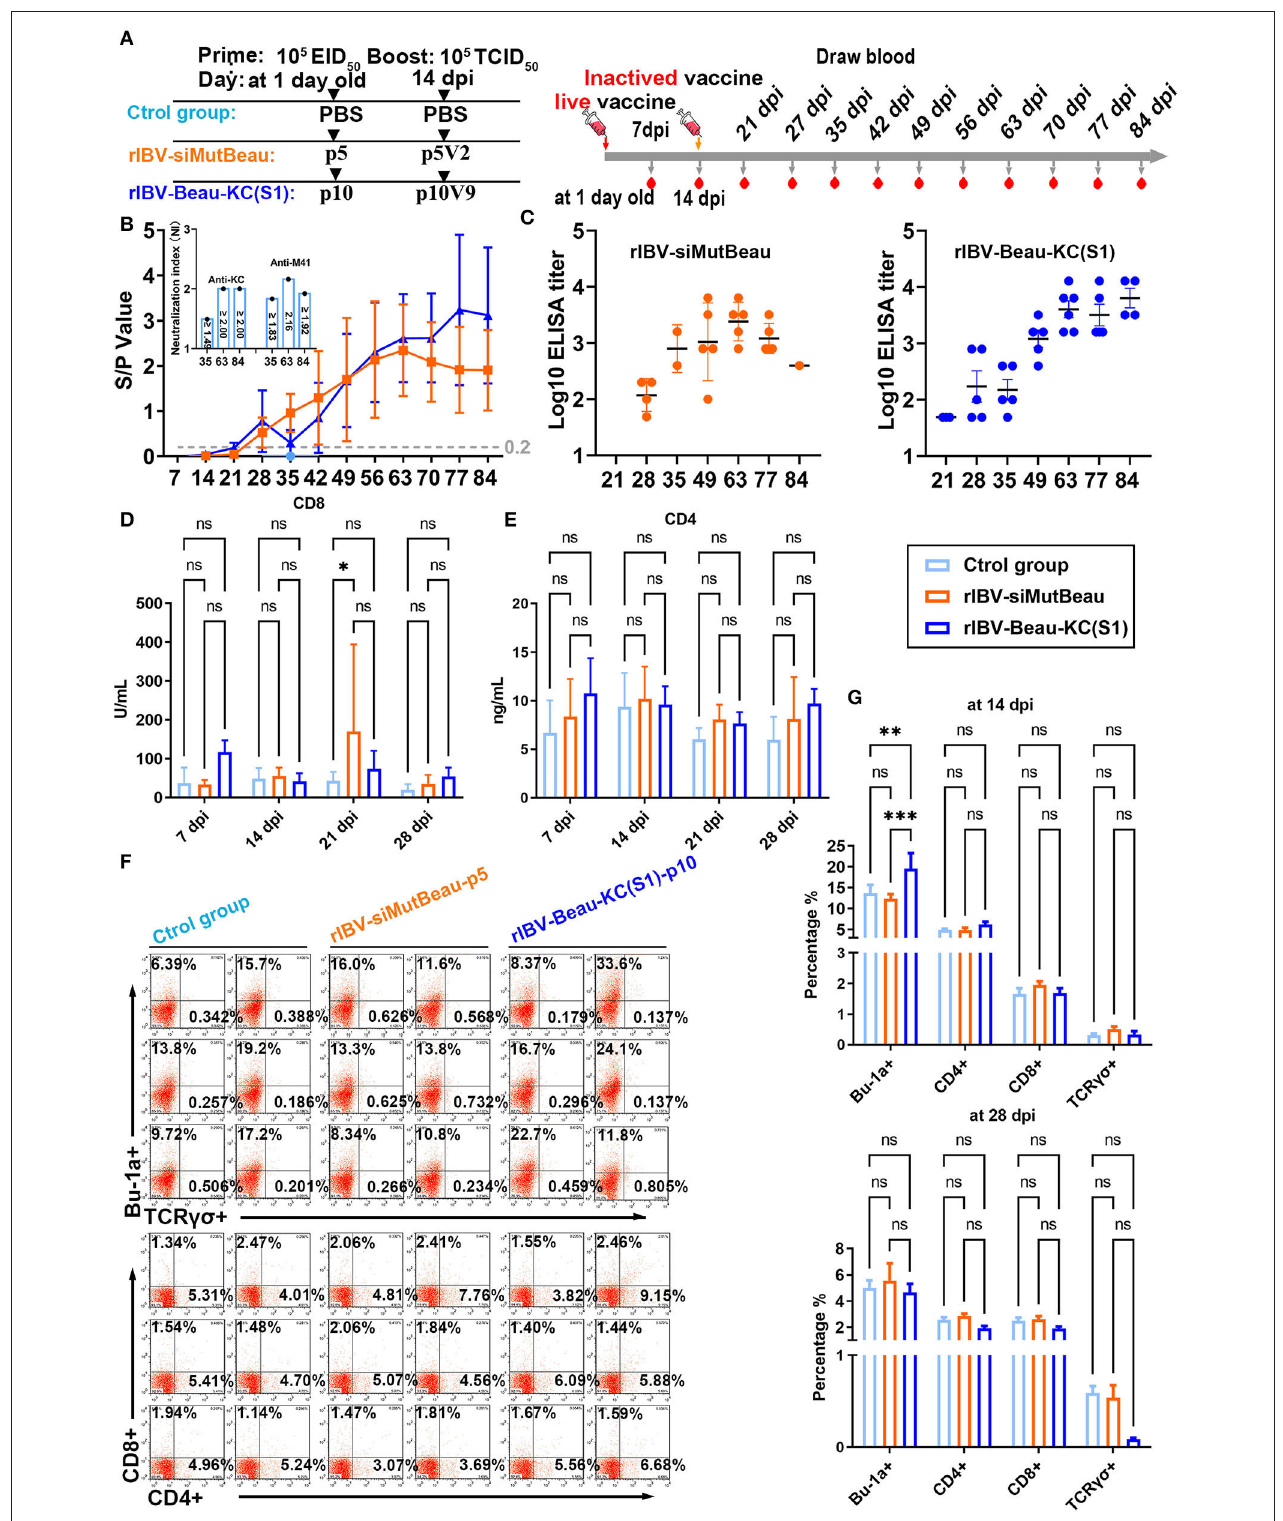
FIGURE 5 | Humoral and cellular immune efficiencies in chickens immunized with rIBV-Beau-KC(S1). (A) Immunization and exsanguination protocol. Prime immunization with PBS, and 105EID50 rIBV-siMutBeau-p5- and 105EID50 rIBV-Beau-KC(S1)-p10-inactivated vaccines, respectively. Boost immunization with PBS, and 105 TCID50 rIBV-siMutBeau-p5V2- and 105 TCID50 rIBV-Beau-KC(S1)-p10V9-activated vaccines, respectively. Blood samples were collected weekly after